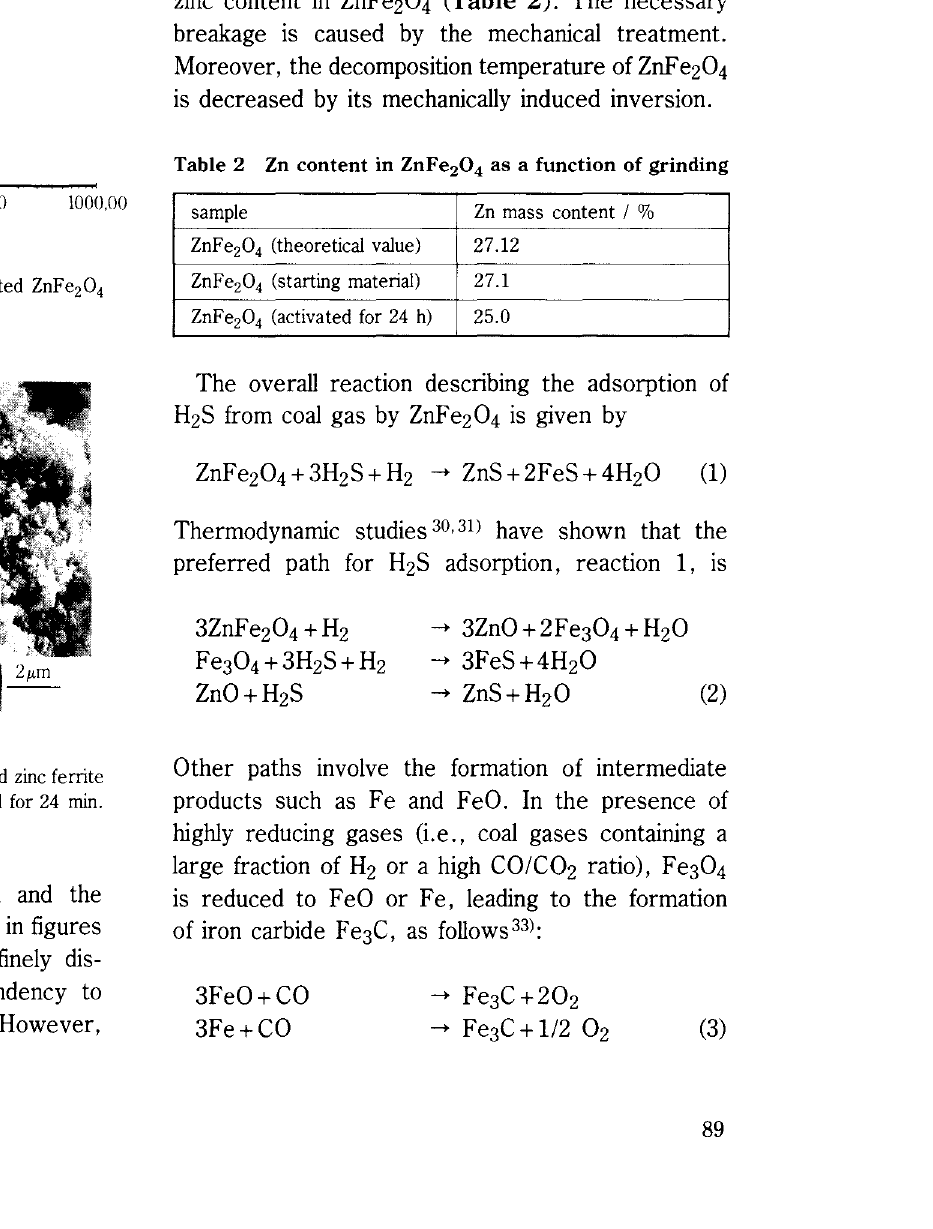
Fig. 3 Particle size distribution of (24 min.) activated ZnFe 2 0 4 (distribution curve)